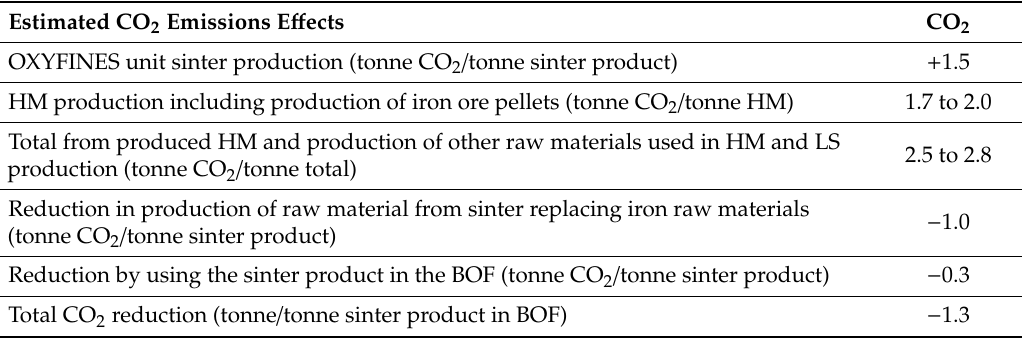
Table 6. Potential CO 2 e ff ect in a holistic view from OXYFINES sinter use in the steel